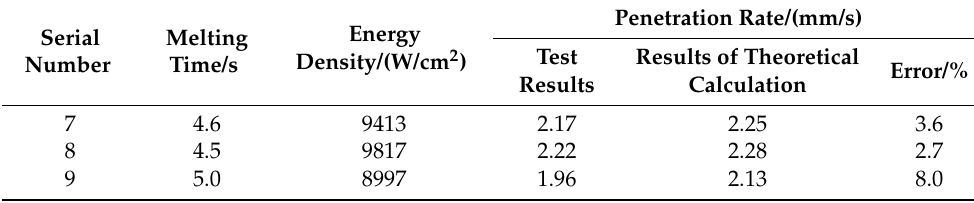
Table 4. Results of